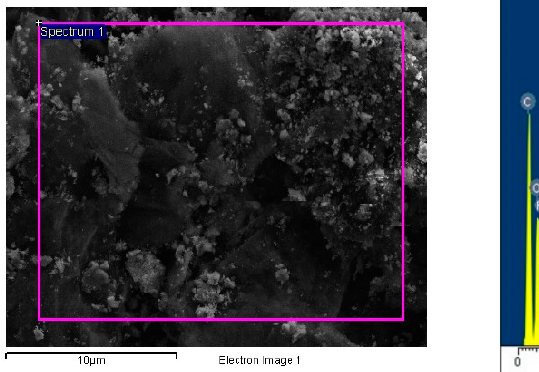
Figure 5. ( a ) N 2 adsorption–desorption isotherm of CuFe 2 O 4 -70%/rGO/HNT. ( b ) Pore size distribution of CuFe 2 O 4 -70%/rGO/HNT.